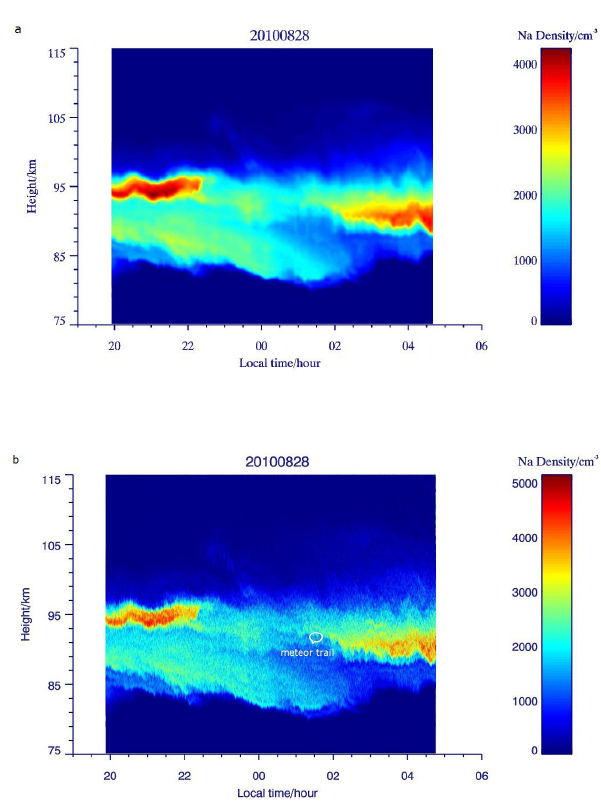
Fig. 1. Na density variations with time and height observed at dif- ferent time resolutions on the night of 28 August 2010: (a) 5min; (b)